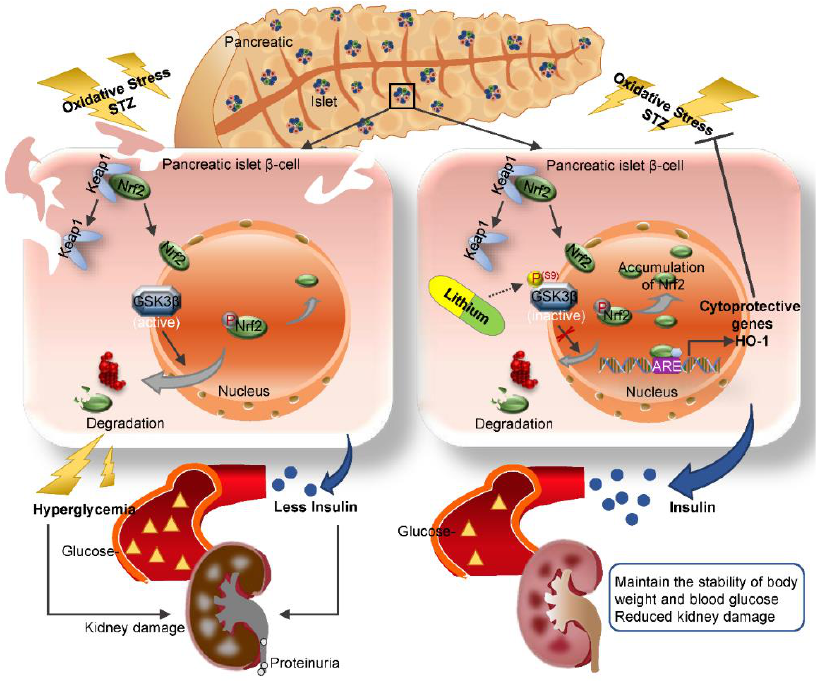
Figure 8. A schematic diagram depicts the protective effect of microdose lithium therapy on pancreatic islet destruction and renal impairment in streptozotocin-elicited diabetes. As a master regulator of the antioxidant response, Nrf2 is critical for sustaining redox homeostasis and cellular integrity. Under basal condition, Nrf2 is sequestered in the cytoplasm and associated with the actin anchored Kelch-like ECH-associated protein 1 (Keap1). Upon its activation triggered by oxidative stress, Nrf2 dissociates from Keap1 and subsequently translocates into the nucleus, where, Nrf2 recognizes and binds to a conserved antioxidant response element (ARE) and induces transcription of a battery of chemoprotective antioxidant genes, including those encoding antioxidant proteins like heme oxygenase (HO-1). Upon islet β-cell injury elicited by streptozotocin (STZ), oxidative stress is triggered and induces a spontaneous Nrf2 antioxidant response for self-defense, which is highly regulated by GSK3β, a key player in dictating Nrf2 nuclear exclusion and degradation and thereby in switching off the self-protective antioxidant stress response after injury. In response to injury, GSK3β is overactivated and thus Nrf2 antioxidant defense is greatly blunted, leading to β-cell necrosis, islet destruction, reduced production of insulin, hyperglycemia, diabetes and related complications like diabetic kidney impairment. This pathogenic process could be targeted by lithium, a standard inhibitor of GSK3β. Shown in this study in streptozotocin-induced murine models of T1D, microdose lithium therapy was able to induce inhibitory phosphorylation of GSK3β and reinforce the Nrf2 antioxidant response in β-cells, resulting in a protective effect on pancreatic islet destruction, diabetes and renal impairment.